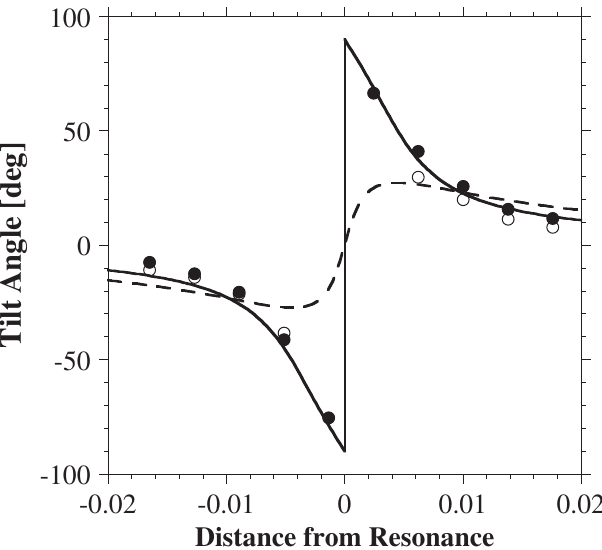
FIG. 3. Measured beam tilt at the SPring-8 storage ring. The full (open) circles denote the measurement result by the beam profile monitor (interferometer) and the solid line displays the expected inclination by the formula at the position of the monitors. The dotted line indicates the expected inclination at the center of a straight